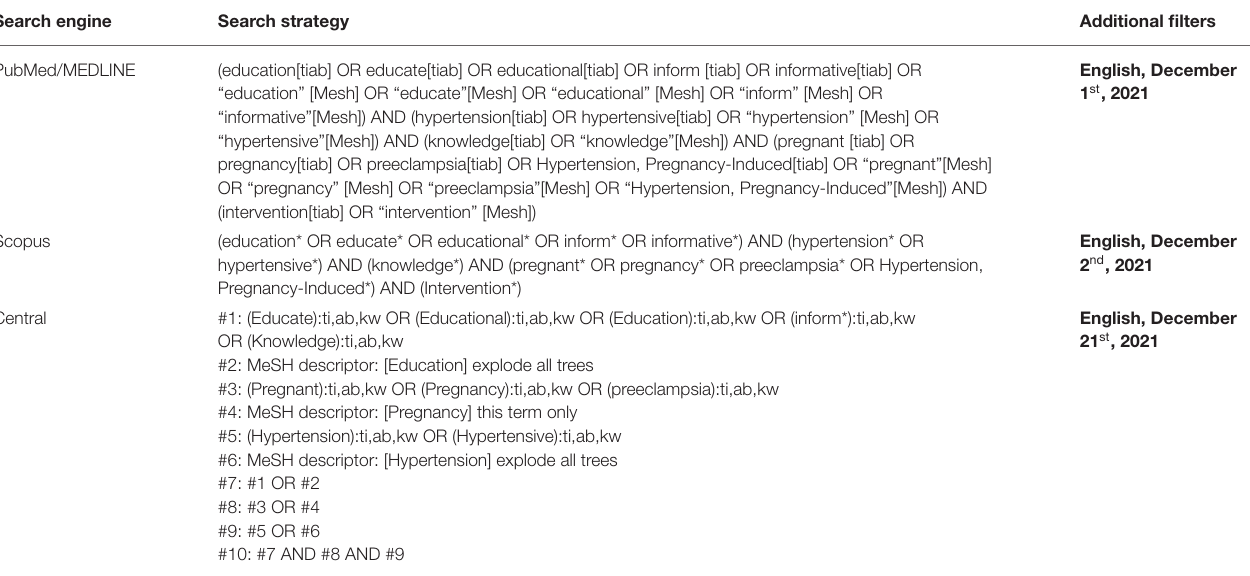
TABLE 1 | Search strategies for PubMed, Scopus, and central databases. Search engine Additional